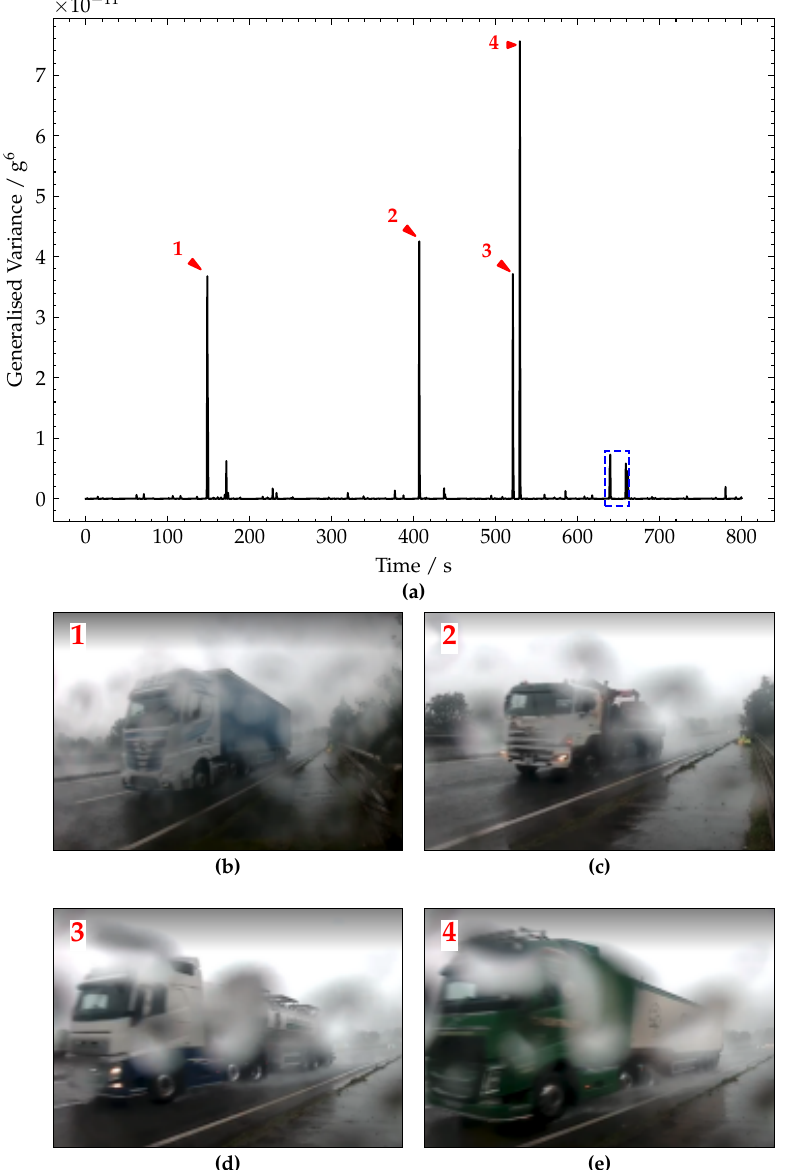
Figure 14. ( a ) Plot of generalised variance signal. ( b – e ) Pictures of vehicles corresponding to peaks 1–4,